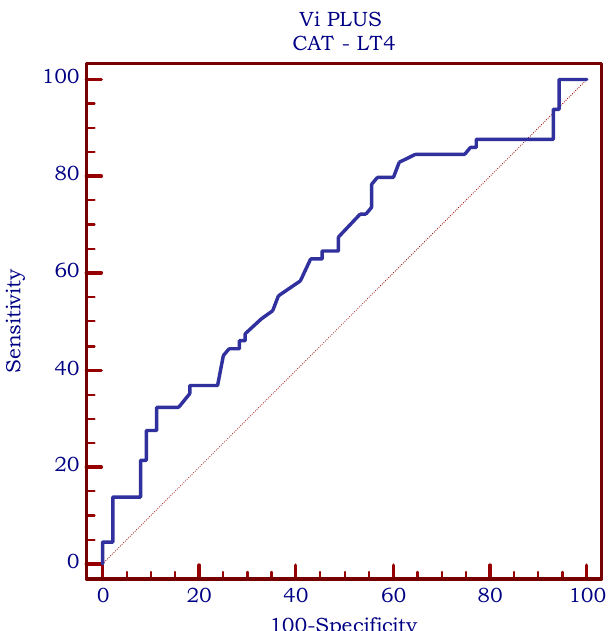
Figure 8. Diagnostic performance of Vi PLUS for predicting the need for levothyroxine supplemen- tation in patients with chronic autoimmune thyroiditis (AUC = 0.63; cut-o ff value >2.6 Pa·s, sensitiv- ity = 80%; speci fi city = 43.18%).